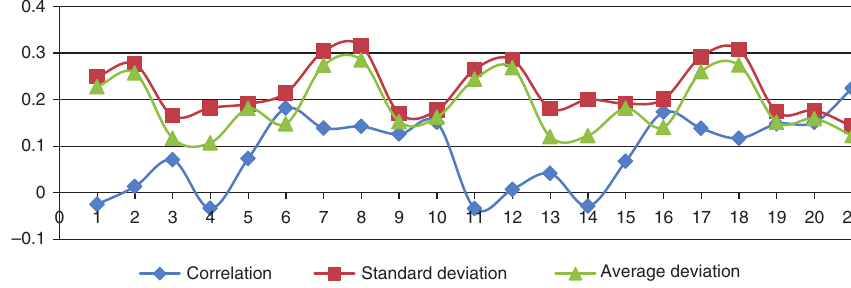
Figure 14: Results for Kaggle Brief Question Answer Evaluation Data Set for Score Class (1–2).